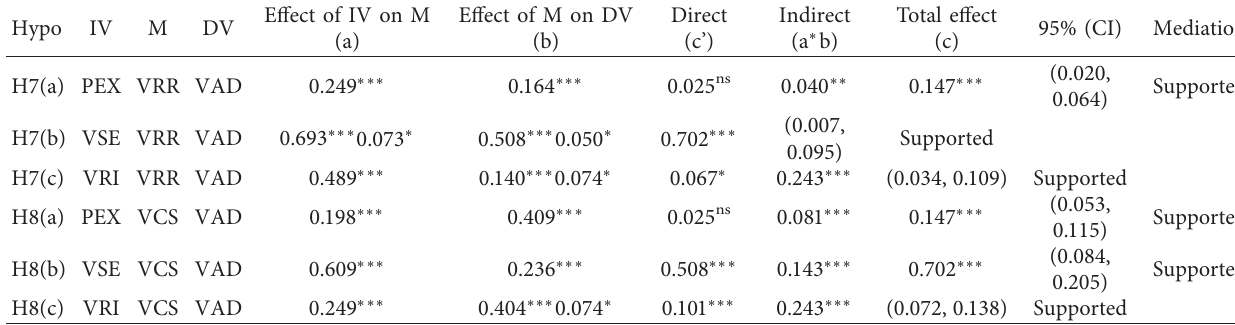
Table 7: Mediation analysis (by bootstrapping).